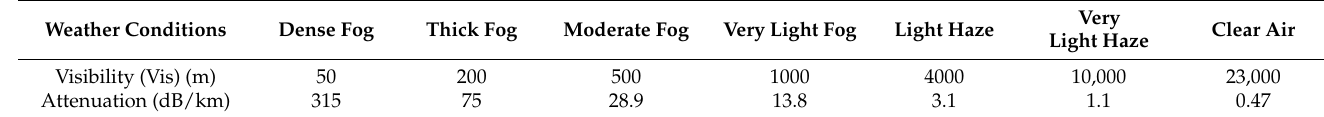
Table 3. International visibility code.